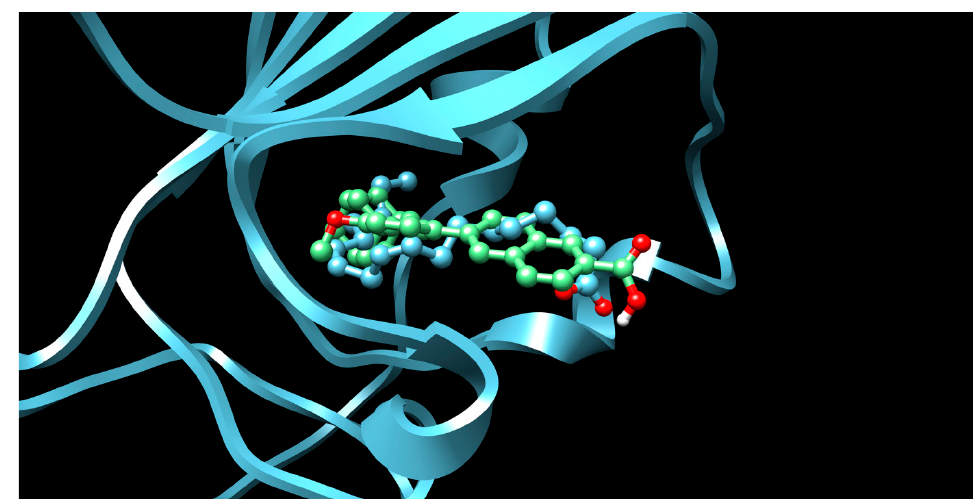
Figure 4. Superimposition of adapalene (green) on linoleate (cyan) in the FABP of spike. We also observed that, even with LA in the FABP, both testosterone and estrogen could bind to the pocket, albeit near the pocket entrance. Figure 5 shows the binding orientation of these sex hormones when the FABP is bound to LA. We calculated the binding energies of LA + testosterone as − 38.54 kcal/mol and LA + estrogen as − 44.54 kcal/mol. The binding energy of LA to the spike alone is − 22.17 kcal/mol, while that of testosterone is − 19.31 kcal/mol and estrogen is − 28.57 kcal/mol. Thus, binding of testosterone to the spike + LA contributes 16.4 kcal/mol and estrogen 25.2 kcal/mol to the cooperative binding energy.